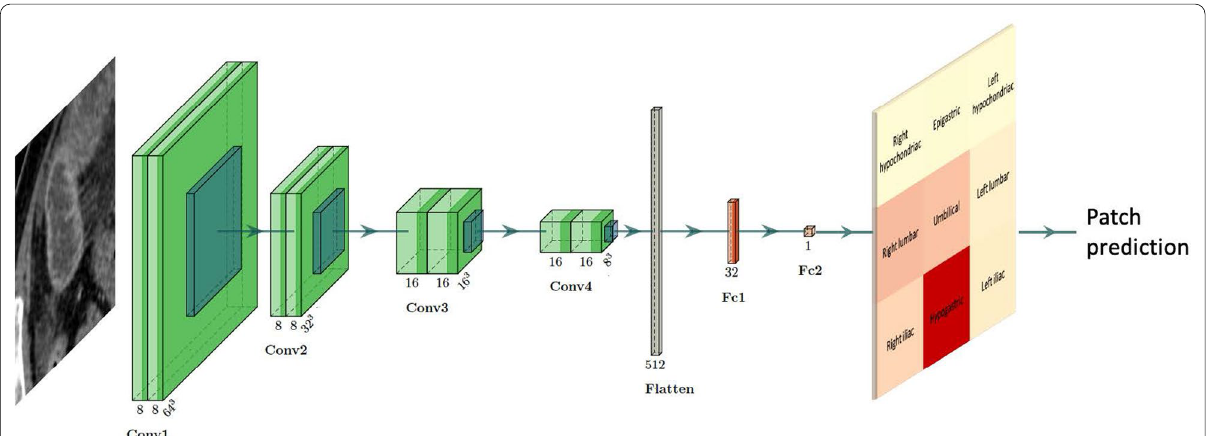
Fig. 2 Model architecture. The 3D convolutional neural network has four convolution blocks followed by two dense layers. After the last layer, the classification score is multiplied by the spatial probability that the patch contains a transition zone, as computed on our training